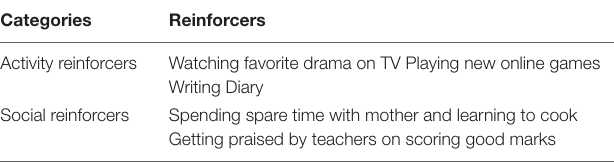
TABLE 1 | Priority-wise reinforcers of the client along with categories.